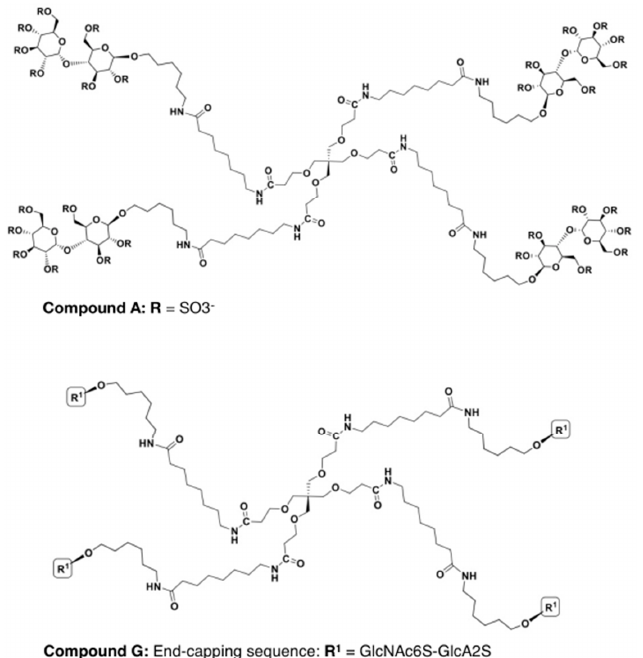
Figure 8. Chemical structure and composition of the novel glycomimetics, compound A and G. Compound A consisted of a tetramer with over-sulfated maltose residues, whereas compound G consisted of an octa-sulfated heparan sulfate tetramer attached to a PET core. A more detailed description of the generation of these compounds can be found in [26].